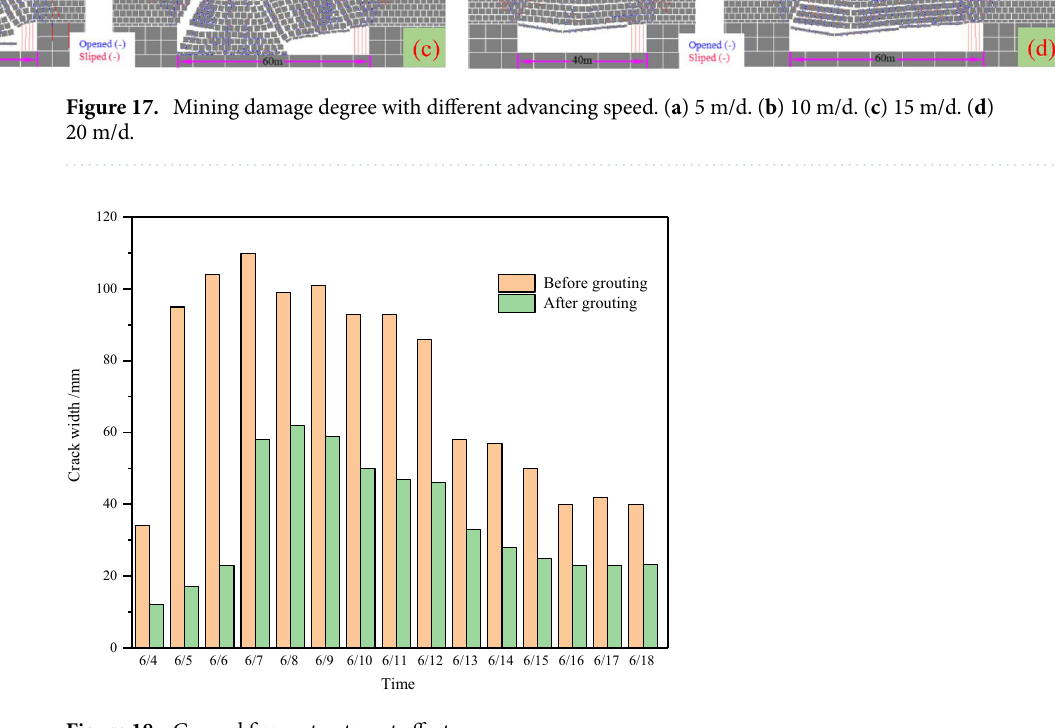
Figure 18. Ground fissure treatment